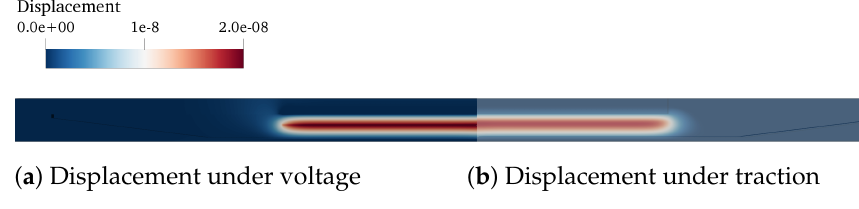
Figure 4. ( Top ) computational domain and boundary condition for the solid part of the inkjet channel. ( Bottom ) a typical block-structured mesh for calculating the actuator lumped parameters. The domain is partitioned uniformly in the central actuating region with a specific grid resolution ∆ x , ∆ y , ∆ z in three directions, x , y , z , respectively.